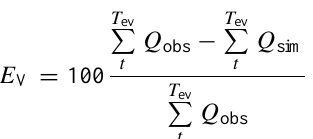
Figure 4: Relative soil moisture temporal pattern for the different soil moisture indicators selected for this study (period March 2009– February 2013). Comparison between the relative values of the ground soil moisture (SM in situ ) obtained from measurements carried out at a depth of 25cm (number of data, N =34972 hourly data) with (a) ERA-Land soil moisture product from ECMWF (SM ERA-LAND(0-28cm) ) obtained from the weighted mean of the 0–7 and 7–28cm products ( N =1450); (b) SWI ASCAT-derived soil moisture product considering the whole data set (SWI ASCAT(all) N =1326, T =147.5 days) and the data set with data in shaded windows removed (SWI ASCAT(mask) , N =631, T =9.5 days); (c) AMSR-E-derived soil moisture product (SWI AMSR-E , T =7.5 days; N =584). R refers to the correlation coefficient, RMSD are the root mean squared differences.